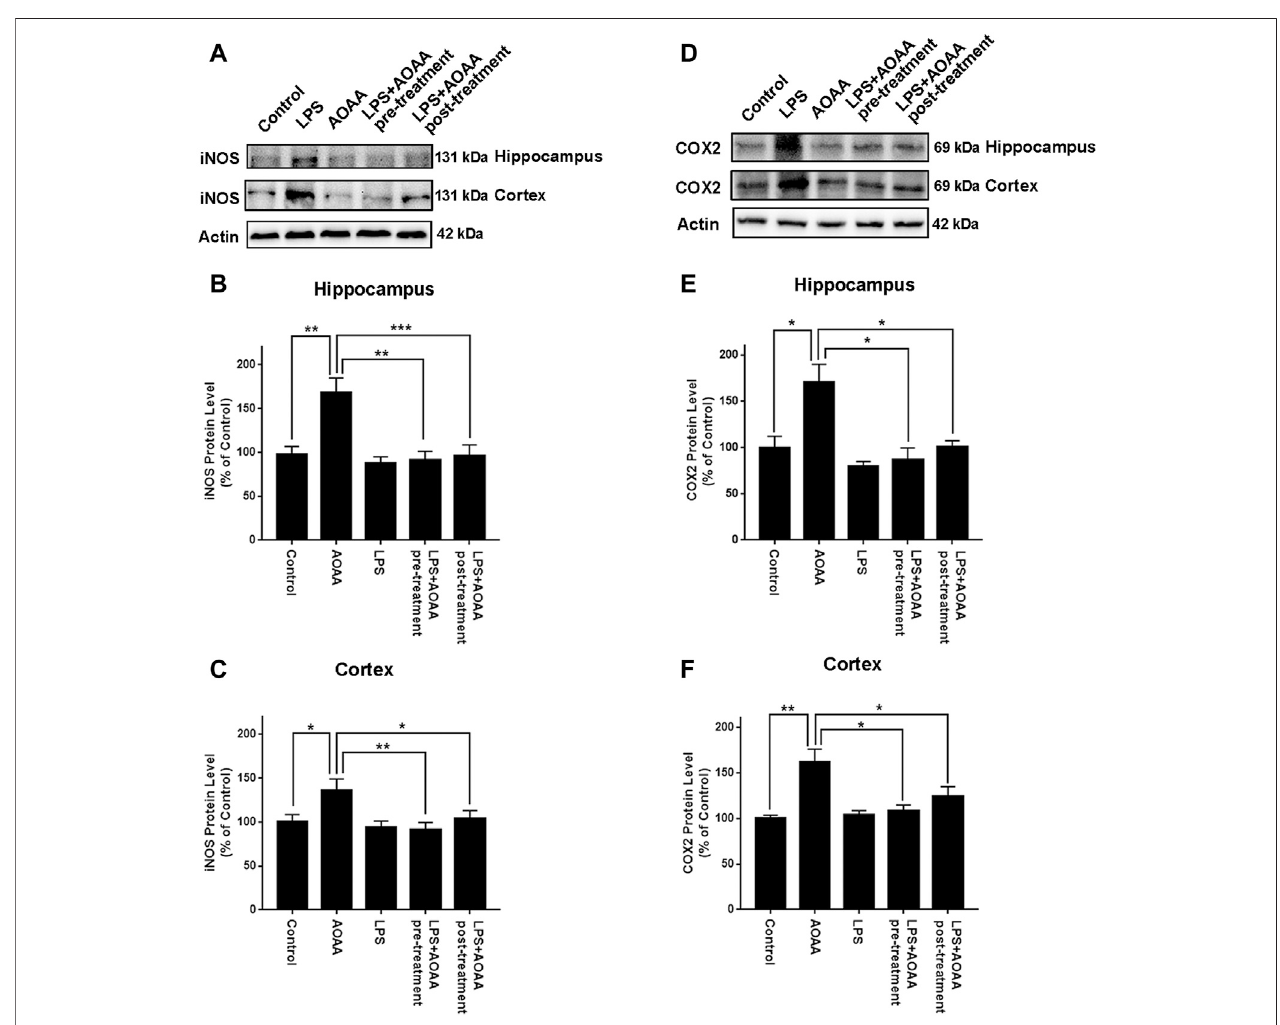
FIGURE 2 | Both AOAA pre-treatment and post-treatment inhibited LPS-induced increases in the protein levels of iNOS and COX2 in the hippocampus and the cerebral cortex of C57BL/6 mice. (A) Western blot assays showed that both pre-treatment and post-treatment of AOAA attenuated LPS-induced increase in the iNOS protein levels in the hippocampus and the cerebral cortex of mice. (B, C) Quanti fi cations of the Western blots showed that both pre-treatment and post-treatment of AOAA signi fi cantly attenuated LPS-induced increase in the iNOS protein levels in the hippocampus and the cerebral cortex of mice. (D) Western blot assays showedthatbothpre-treatmentandpost-treatmentofAOAAattenuatedLPS-inducedincreaseintheCOX2proteinlevelsinthehippocampusandthecerebralcortexof mice. (E,F) Quanti fi cationsoftheWesternblotsshowedthatbothpre-treatmentandpost-treatmentofAOAAsigni fi cantlyattenuatedLPS-inducedincreaseintheCOX2 protein levels in the hippocampus and the cerebral cortex of mice. The mice were administered with LPS (250 μ g/kg, i.p,). AOAA was administered 3 days before LPS administrationor3 daysafterLPSadministration.7 daysaftertheLPSadministration,Westernblotassayswereconducted. N (cid:2) 5.*, p < 0.05,**, p < 0.01;***, p < 0.001.